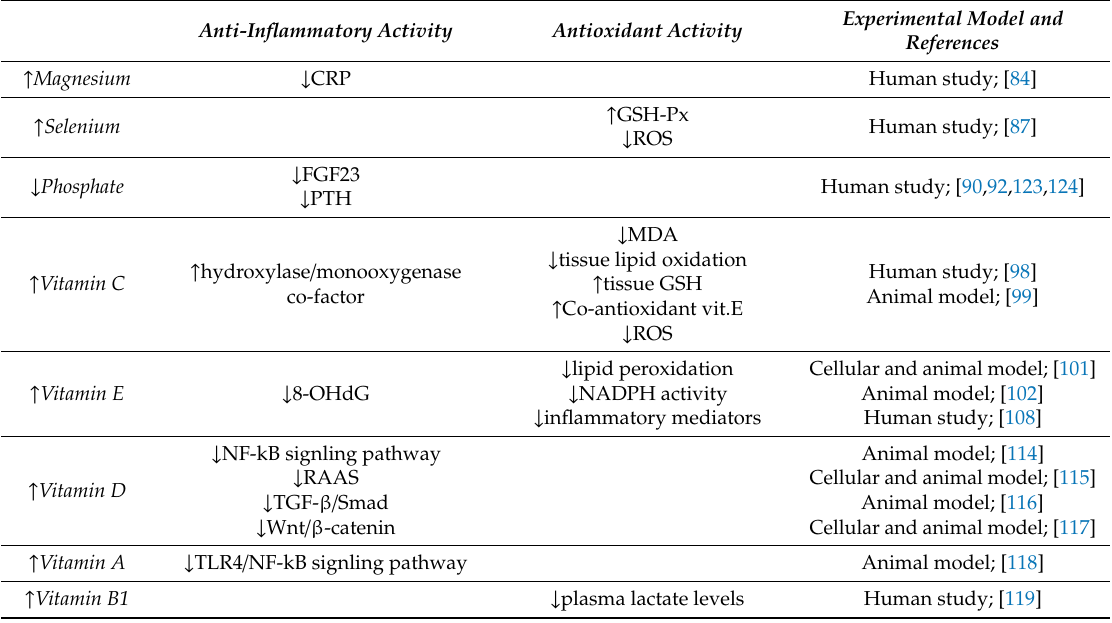
Table 1. Anti-inflammatory and antioxidant activities of the minerals (selenium and phosphate) and vitamins detailed in this study, with evaluation of the pathways involved. Decreased ( ↓ ) or increased ( ↑